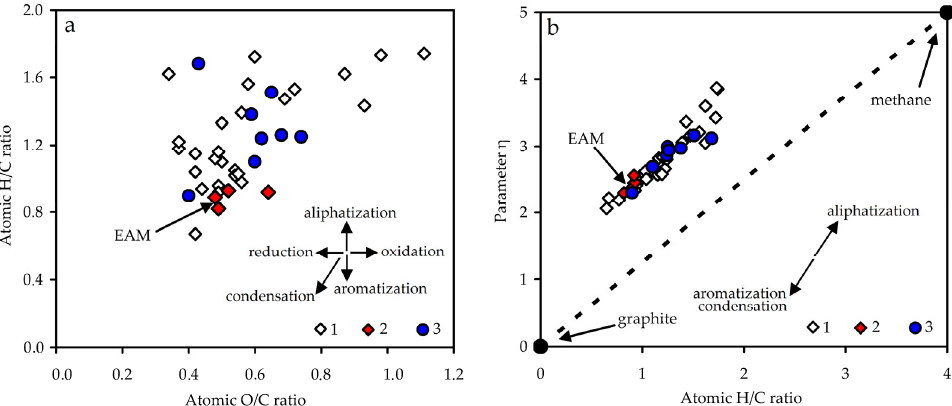
Figure 4. Van Krevelen diagram for known melanoidins ( a ) and atomic H/C as a function of parameter η ( b ). 1—fungal melanoidins; 2—plant melanoidins of fermentation origin; 3—plant melanoidins of non-fermentation origin.